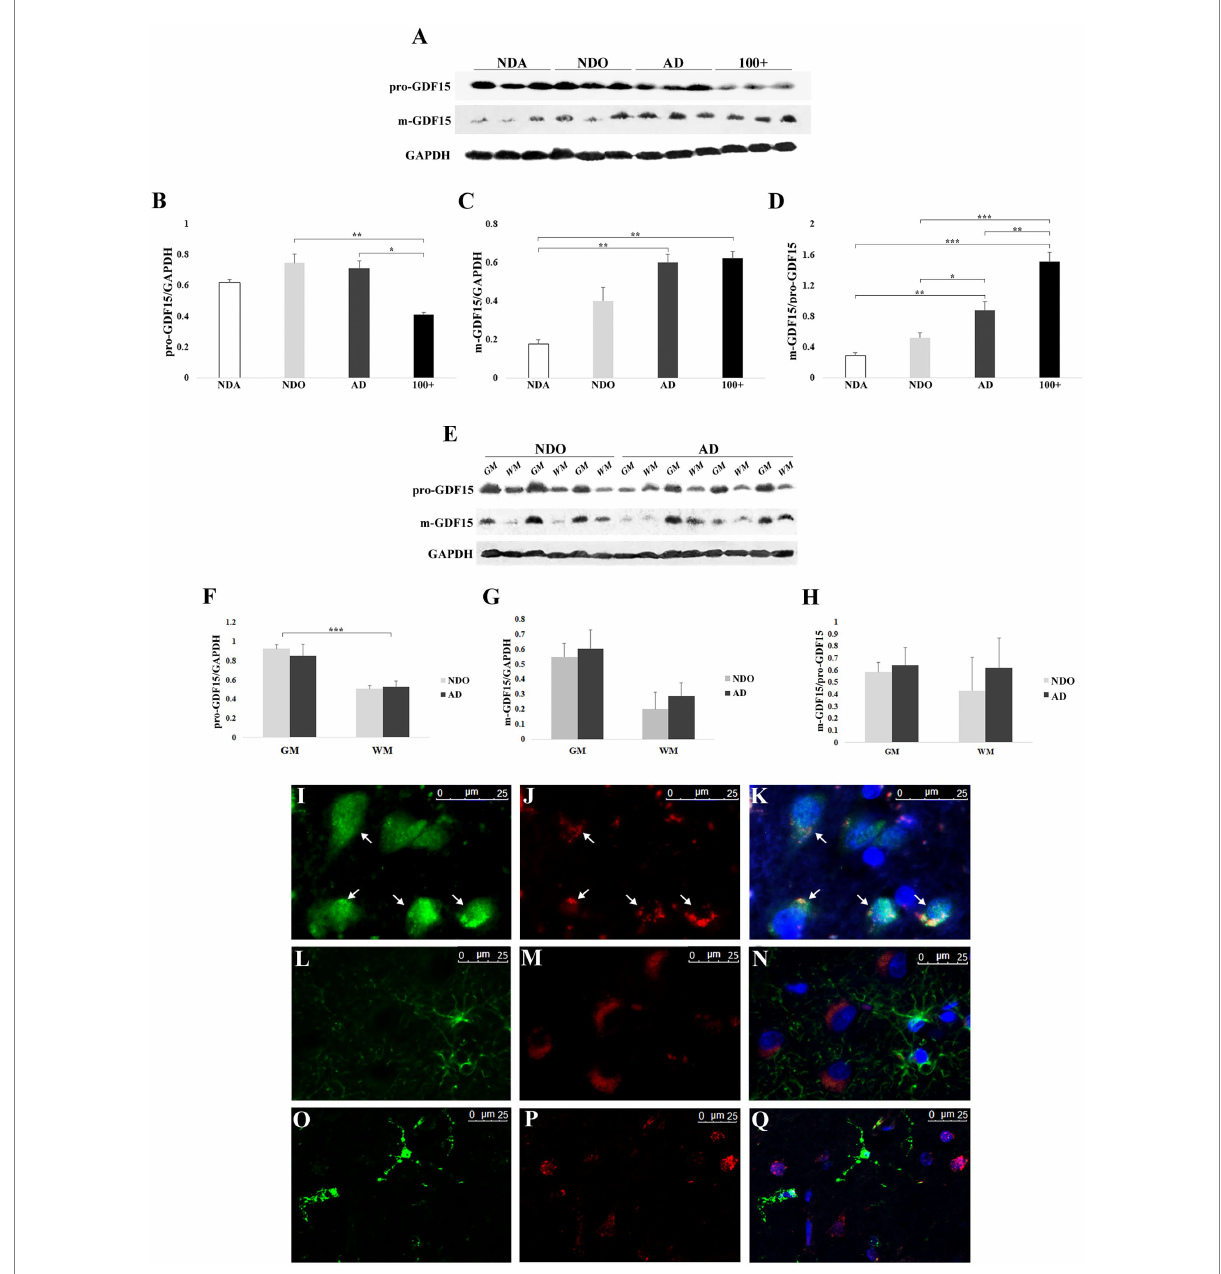
FIGURE 3 Western blotting and immunofluorescence analyses of GDF15 in the frontal cortex. (A) Representative immunoblotting image of pro-GDF15, m-GDF15, and GAPDH in frontal cortex. Relative protein expression of (B) pro-GDF15, (C) m-GDF15, and (D) m-GDF15/pro-GDF15 ratio in frontal cortex from three non-demented adults (NDA), 11 non-demented old subjects (NDO), 11 AD patients (AD) and three centenarians (100+). (E) Immunoblotting image of pro-GDF15 and m-GDF15 in gray (GM) and white (WM) matter of frontal cortex from 3 NDO and 4 AD. Relative protein expression of (F) pro-GDF15, (G) m-GDF15 and (H) m-GDF15/pro-GDF15 in GM ad WM from 3 NDO and 4 AD. (I-Q) Fluorescence microscopy analysis in frontal cortex. (I) NeuN (green), (J) GDF15 (red), and (K) merge; nuclei (DAPI). Arrows indicate colocalization of GDF15 and NeuN signals. (L) GFAP (green), (M) GDF15 (red), and (N) merge; nuclei (DAPI). (O) TMEM119 (green), (P) GDF15 (red), and (Q) merge; nuclei (DAPI). The bars represent mean ± SE. Student’s t and one-way ANOVA tests with Bonferroni correction were applied. Western blotting quantification was performed using ImageJ software and normalized to GAPDH expression. * p < 0.05. ** p < 0.01. *** p < 0.001.